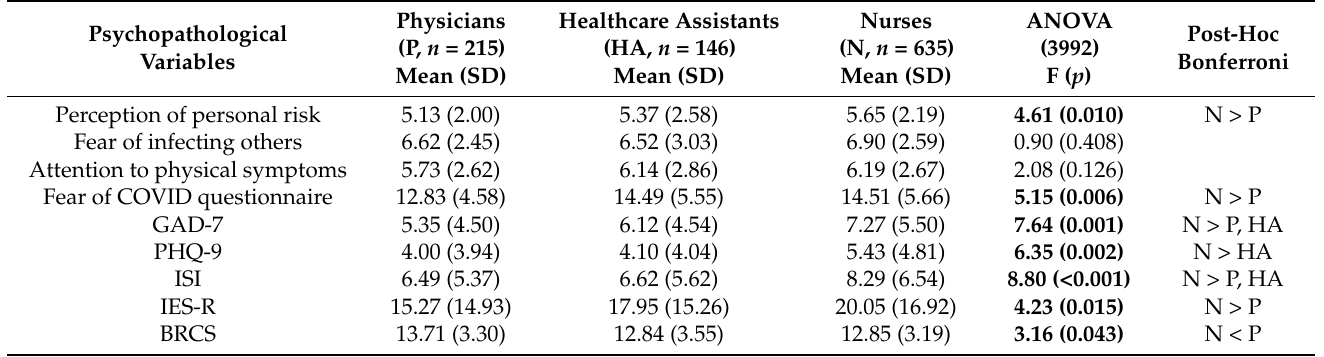
GAD-7: 7-item Generalized Anxiety Disorder scale; PHQ-9: 9-item Patient Health Questionnaire; ISI: Insomnia Severity Index; IES-R: Impact of Event Scale-Revised; BRCS: Brief Resilient Coping Scale. Significant p values are indicated in bold (significance considered p <